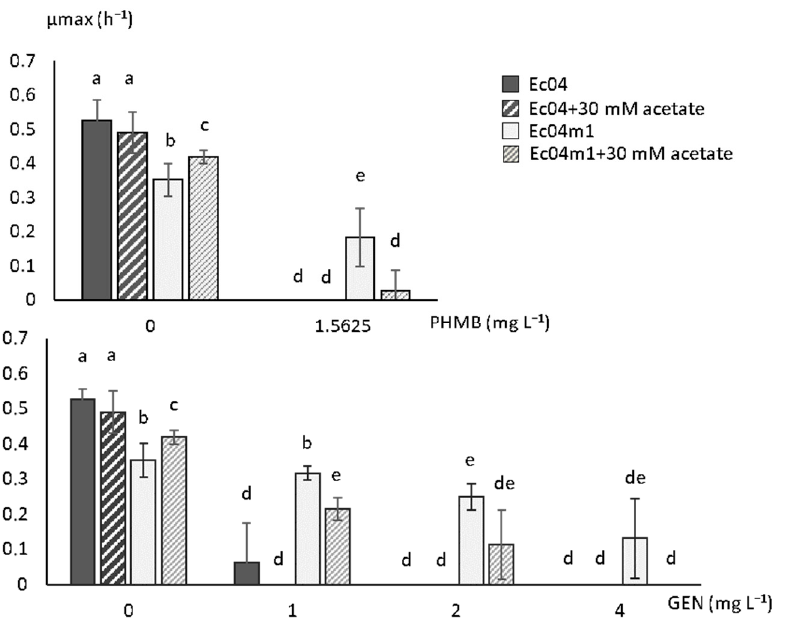
Figure 4. Effect of acetate medium supplementation (30 mM) on maximal growth rate (µmax) for parental strain Ec04 and Ec04m1 variant in the presence of PHMB or GEN. Different letters upon the SD bars indicate significant differences between µmax or lag mean values (T-test. p < 0.05).